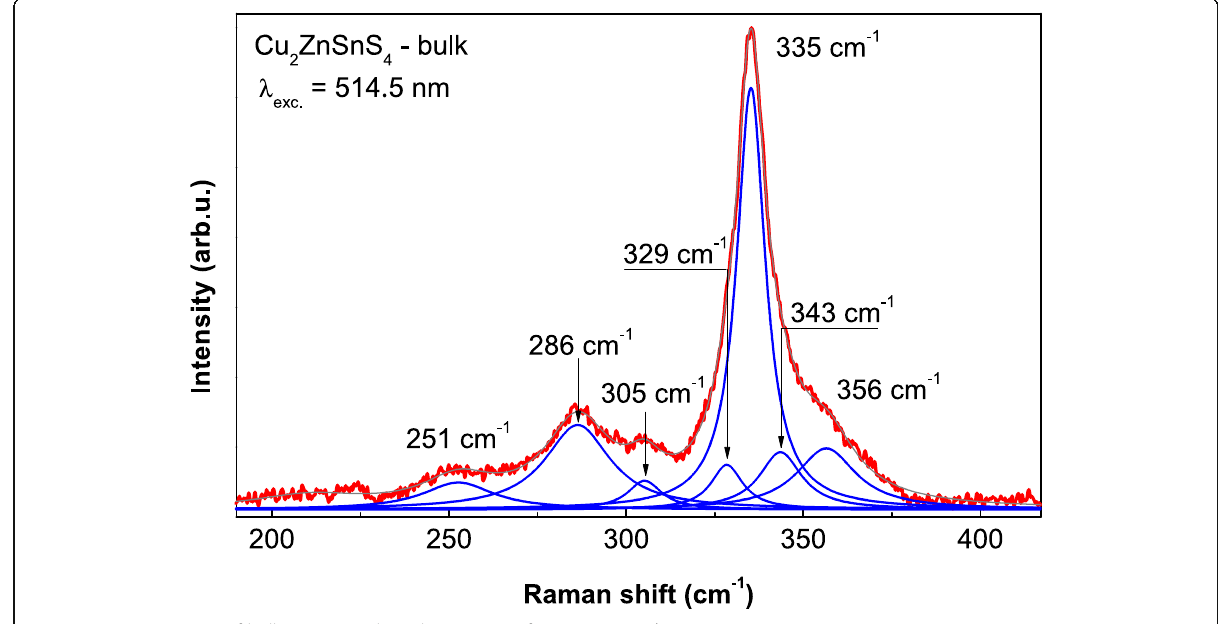
Fig. 4 Raman spectrum of bulk CZTS sample with Lorentzian fits ( I ~ 0.5 mW; λ = 514.5